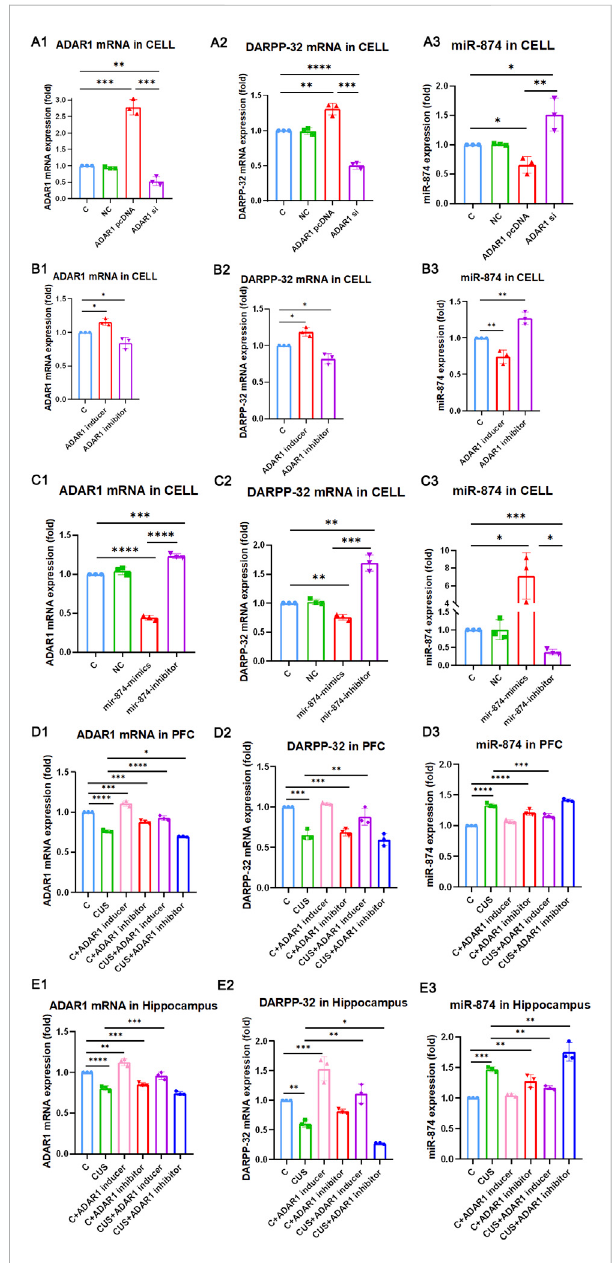
FIGURE 4 ADAR1impactsDARPP-32expression via miR-874-3p invivo and in vitro . (A1-A3) ADAR1 high/low (A1) expression impacts DARPP-32 mRNA (A2) and miR-874-3p (A3) expression, respectively. (B1-B3) ADAR1 inducer (IFN- γ ) and ADAR1 inhibitor (EHNA) impact ADAR1 mRNA (B1) DARPP-32 mRNA (B2) and miR-874-3p (B3) expression, respectively. (C1-C3) miR-874-3p high/low (C3) expression impactsADAR1 (C1)andDARPP-32